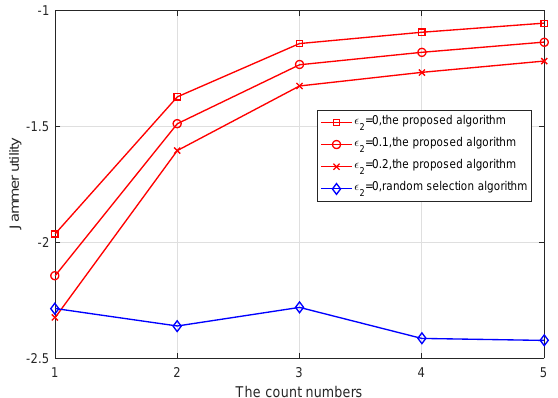
Figure 8. Jammer’s utility comparison under different algorithms with eavesdropping